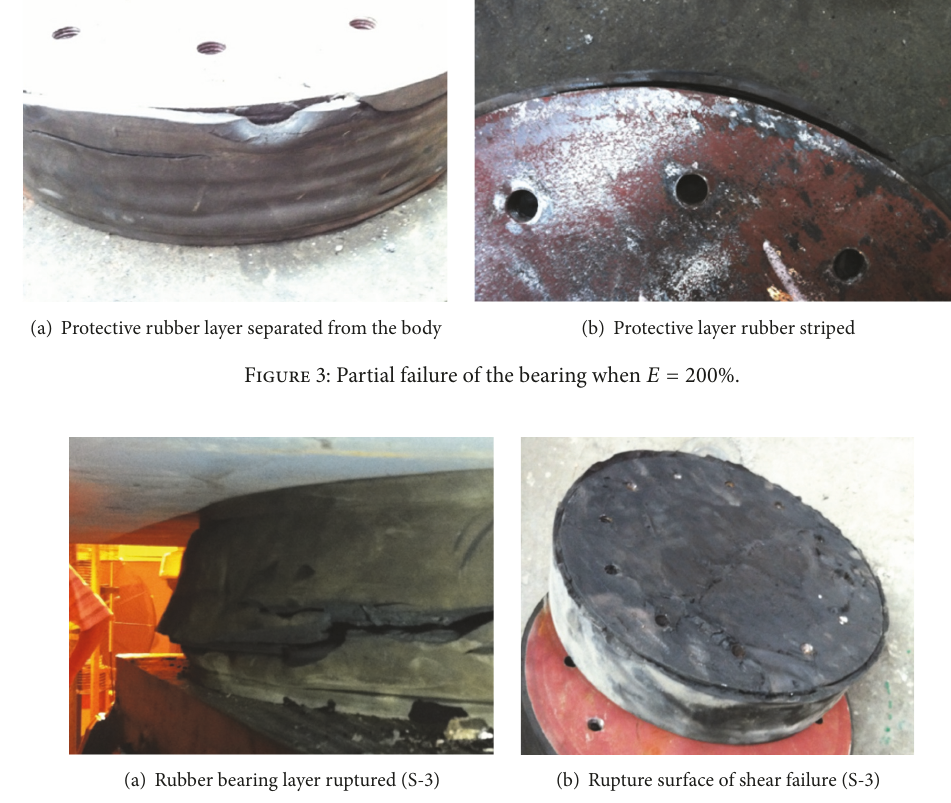
Figure 4: Shear failure of the bearings after 𝐸 ≥ 350 %.